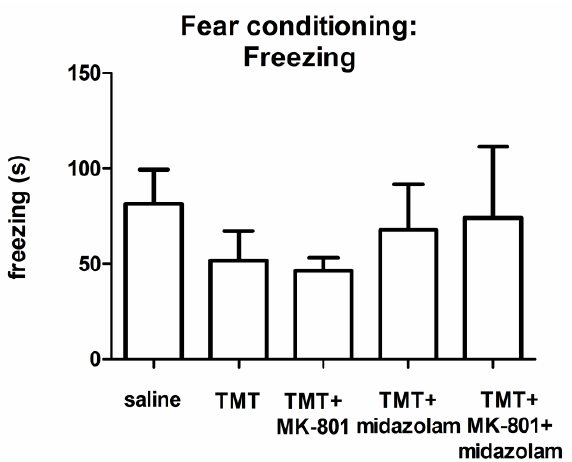
Figure 4. Contextual fear conditioning: Cumulative duration of freezing. Group mean + SEM. No statistically significant differences were found (ANOVA).